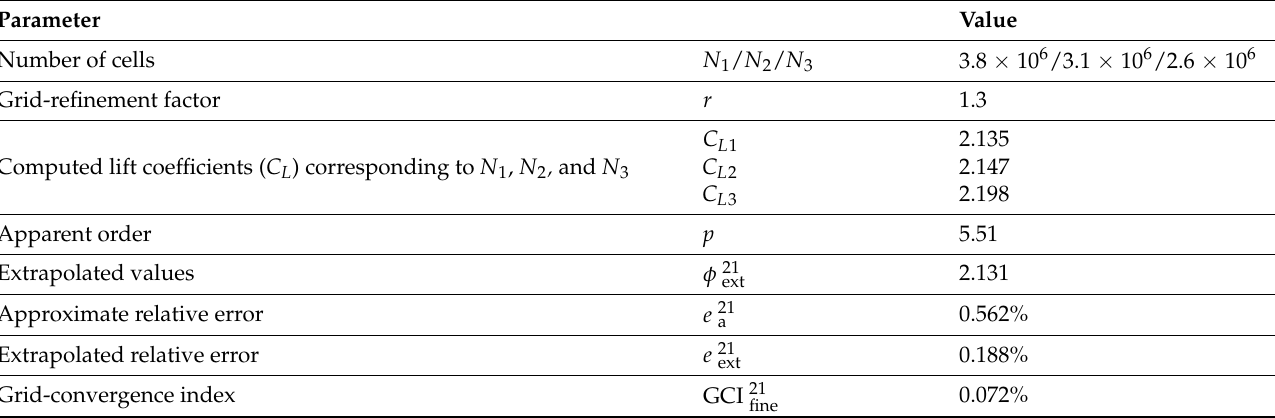
Table 3. Grid-convergence index(GCI) analysis for the external domain of airfoil with fluidic